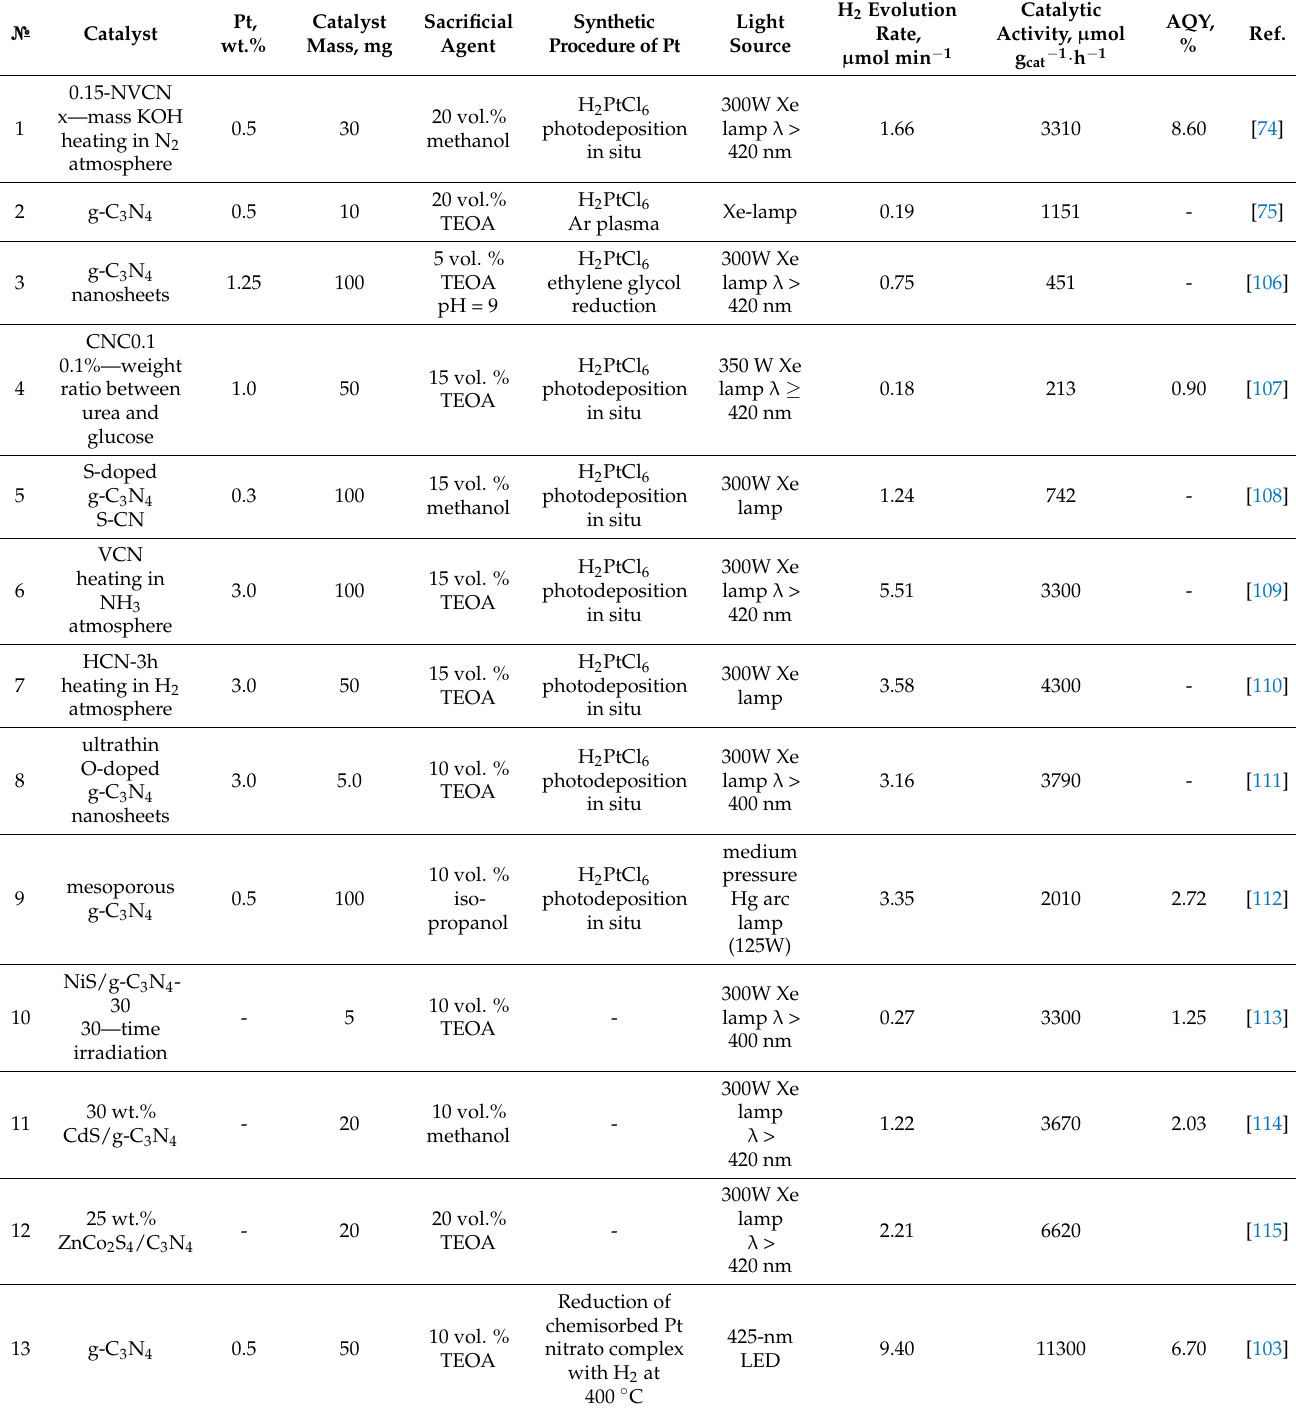
Table 2. Comparison of characteristics of the Pt/g-C 3 N 4 based photocatalysts for hydrogen produc- tion reported in the literature and the most active photocatalysts described in Table